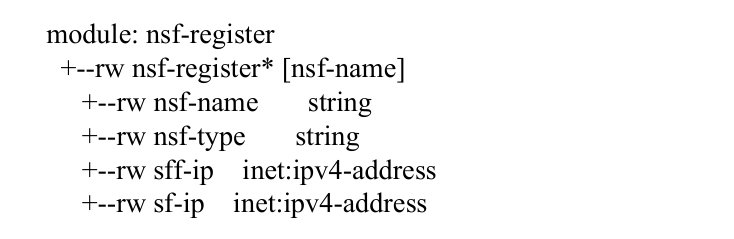
Figure 9. The information model of the registration interface.